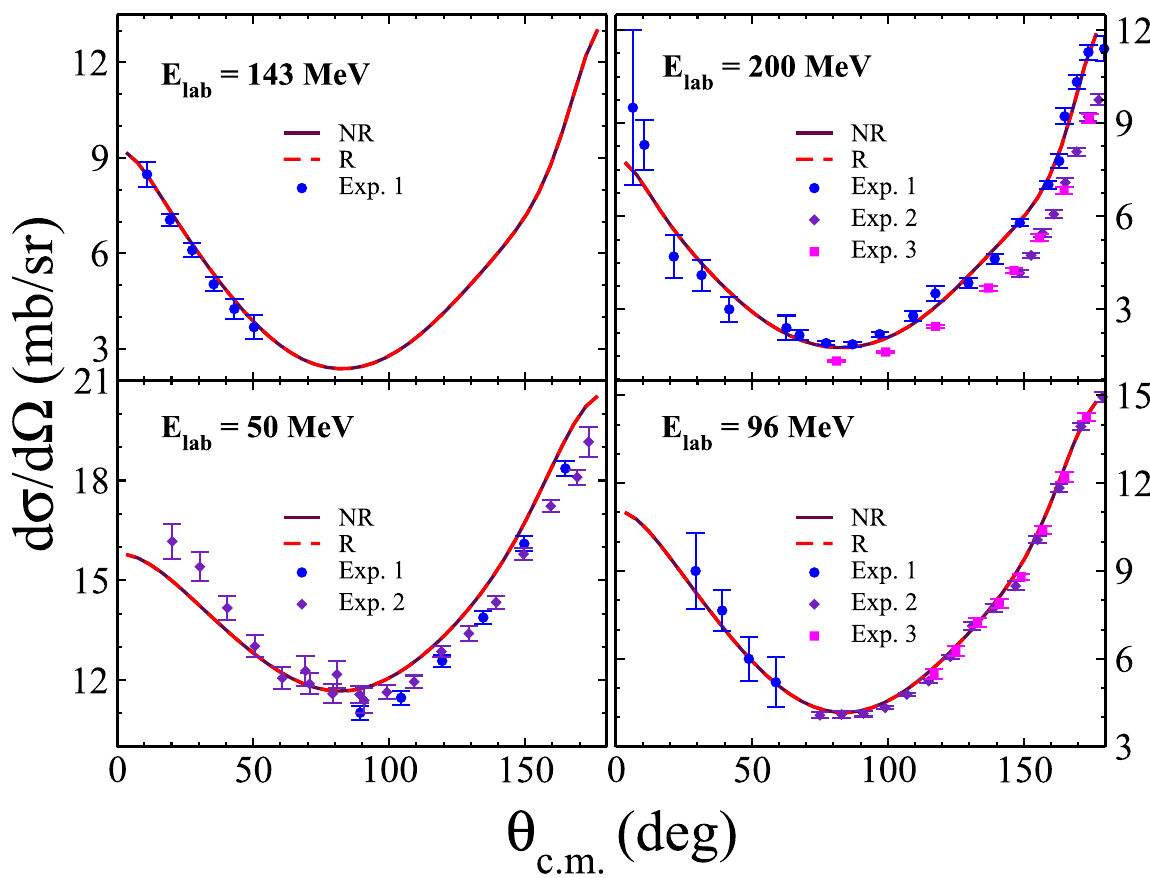
Figure 6. The np differential cross sections calculated for relativistic (solid magenta lines) and nonrelativistic CD-Bonn (dashed red lines) potentials as a function of scattering angle θ c . m . in the CM frame, for the 50, 96, 143 , and 200 MeV. The experimental data are from Refs. 42,43 for incident projectile energies E lab = 50 MeV (Exp. 1 and Exp. 2, respectively), form Refs. 44–46 for E 96 MeV (Exp. 1, Exp. 2, and Exp. 3, E lab lab = = respectively), from Ref. 47 for E lab